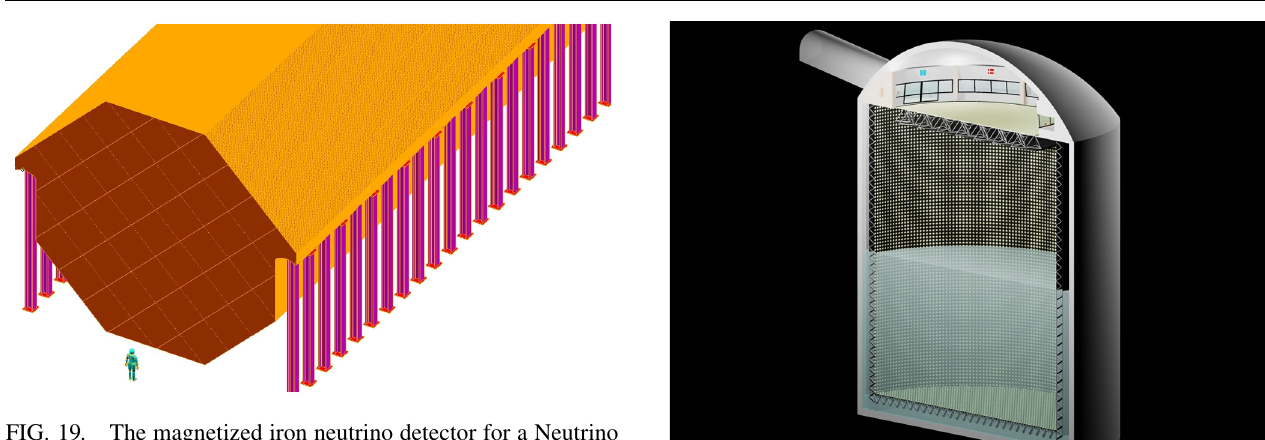
FIG. 19. The magnetized iron neutrino detector for a Neutrino Factory.